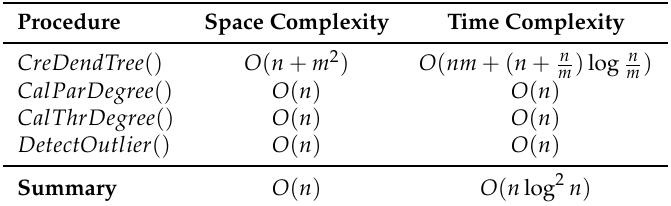
Table 1. Summary of the fault detection based on participation degree (FDP) algorithm complexity, where n is the number of data items in the dataset, m is the maximum number of points in the leaf node, and m is much smaller than n in